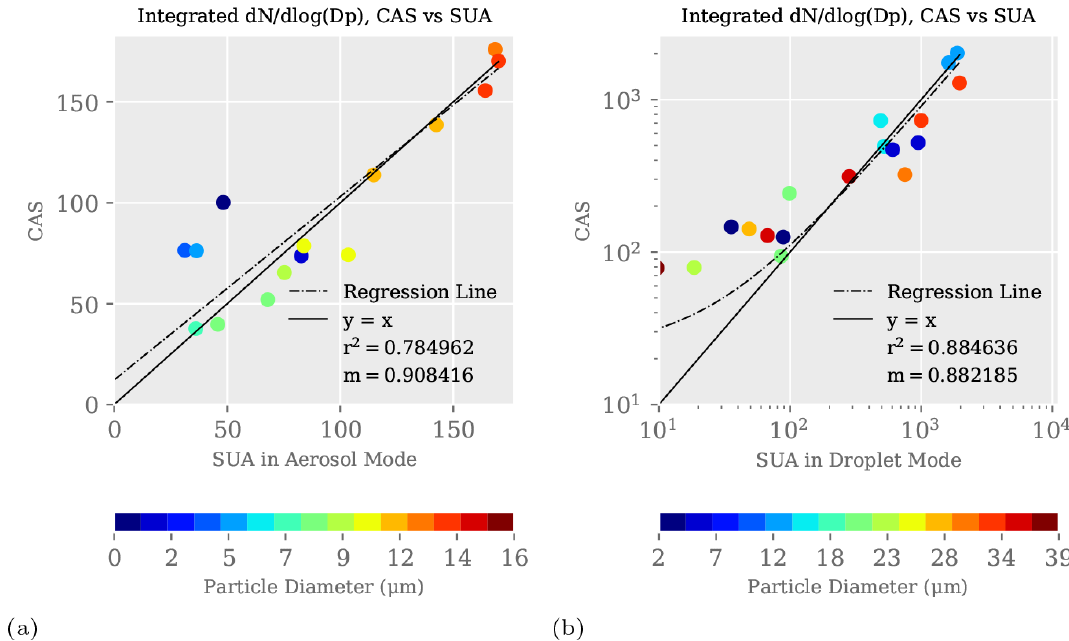
Figure 11. Re-binned d N/ dlog (D p ) 1 : 1 plots. The solid line represents perfect agreement; the dotted line is the regression line using RMAR. The coefficient of determination is represented by r 2 , and m is the gradient of the regression line. In (b) , a log–log scale was used since most values were close to 0; the appearance of a curved regression line in (b) is simply due to the log–log scale. The colour of the points corresponds to the bin geometric mean diameter, which is shown on the colour bar beneath the graph.